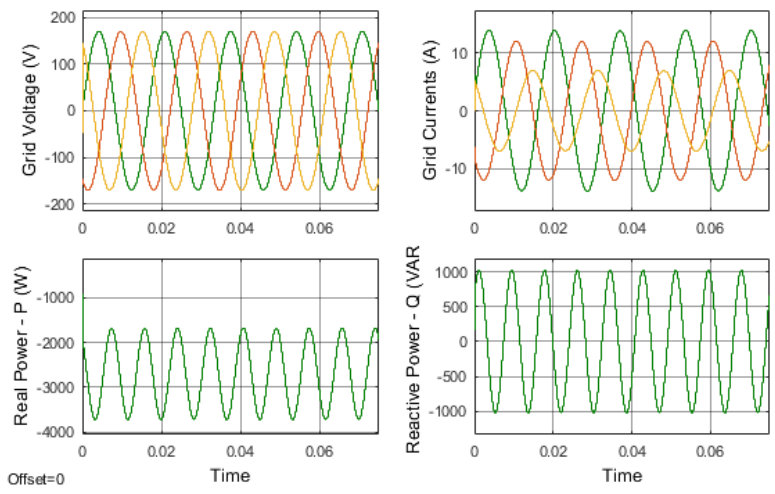
Figure 4. Neglecting the grid impedance under unbalanced load.